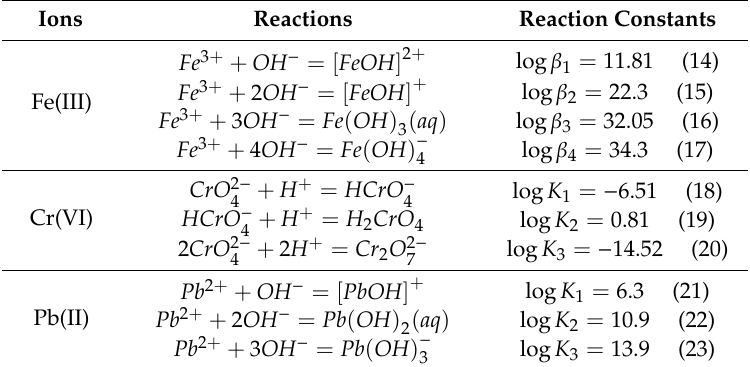
Table 4. Equilibrium reaction and corresponding coe ffi cients of di ff erent